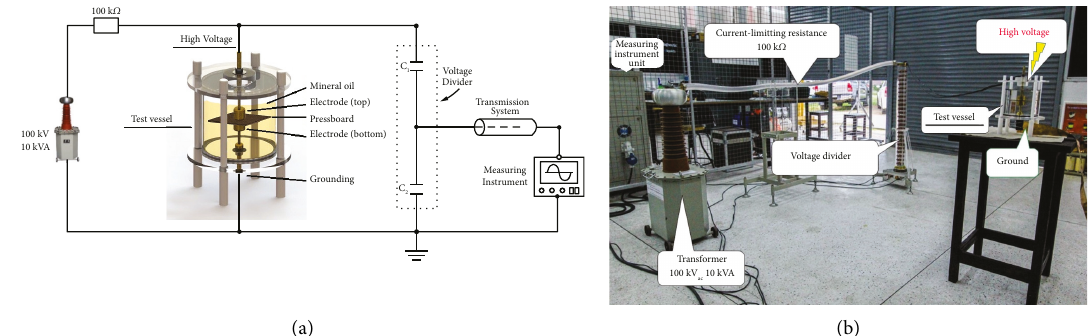
Figure 5: Preparation for measuring AC breakdown strengths. (a) Equivalent circuit for AC breakdown testing. (b) Test circuit preparation.